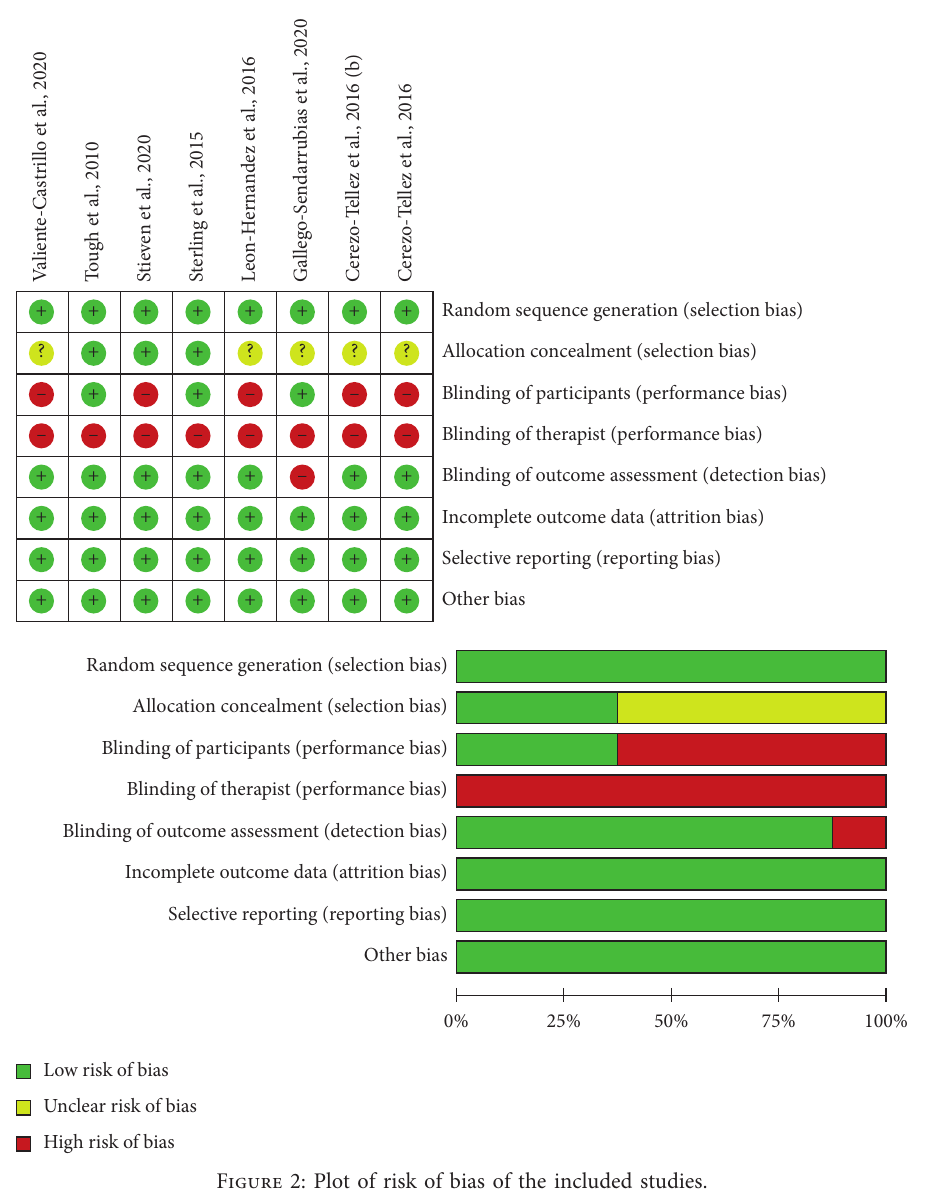
Figure 2: Plot of risk of bias of the included